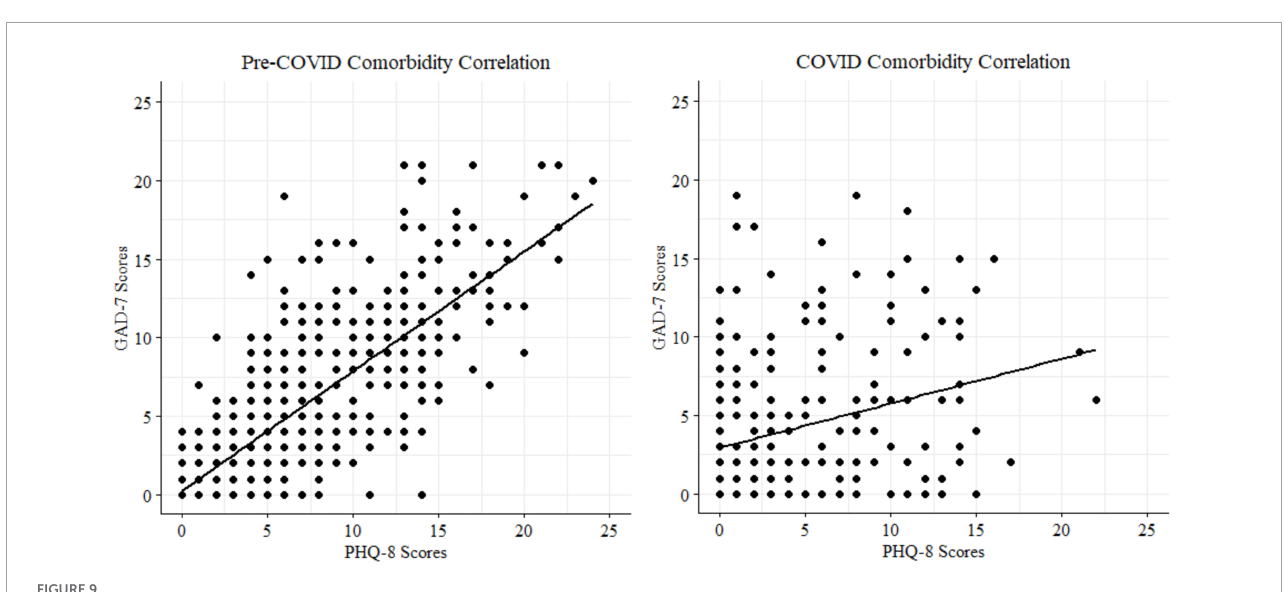
FIGURE9 Cohort correlations between depression and anxiety